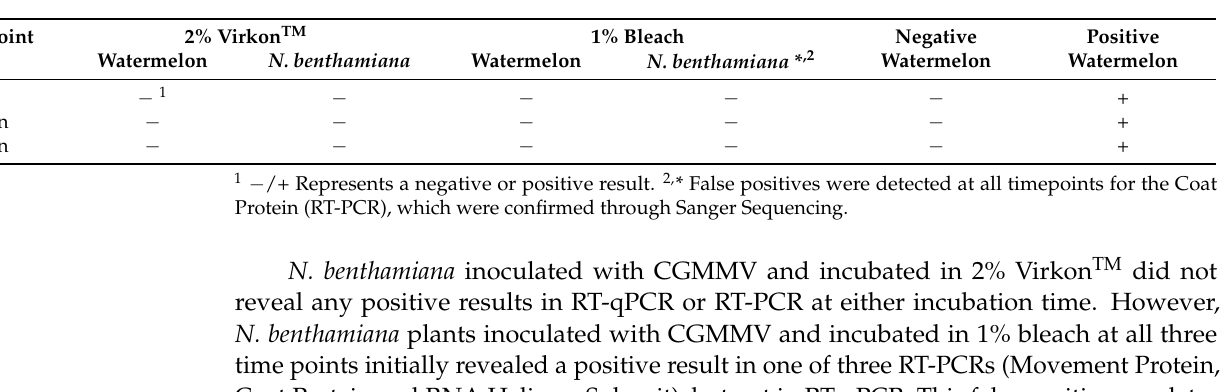
Table 4. N. benthamiana inoculated with CGMMV mixed with 2% Virkon TM or 1% Bleach at three separate contact